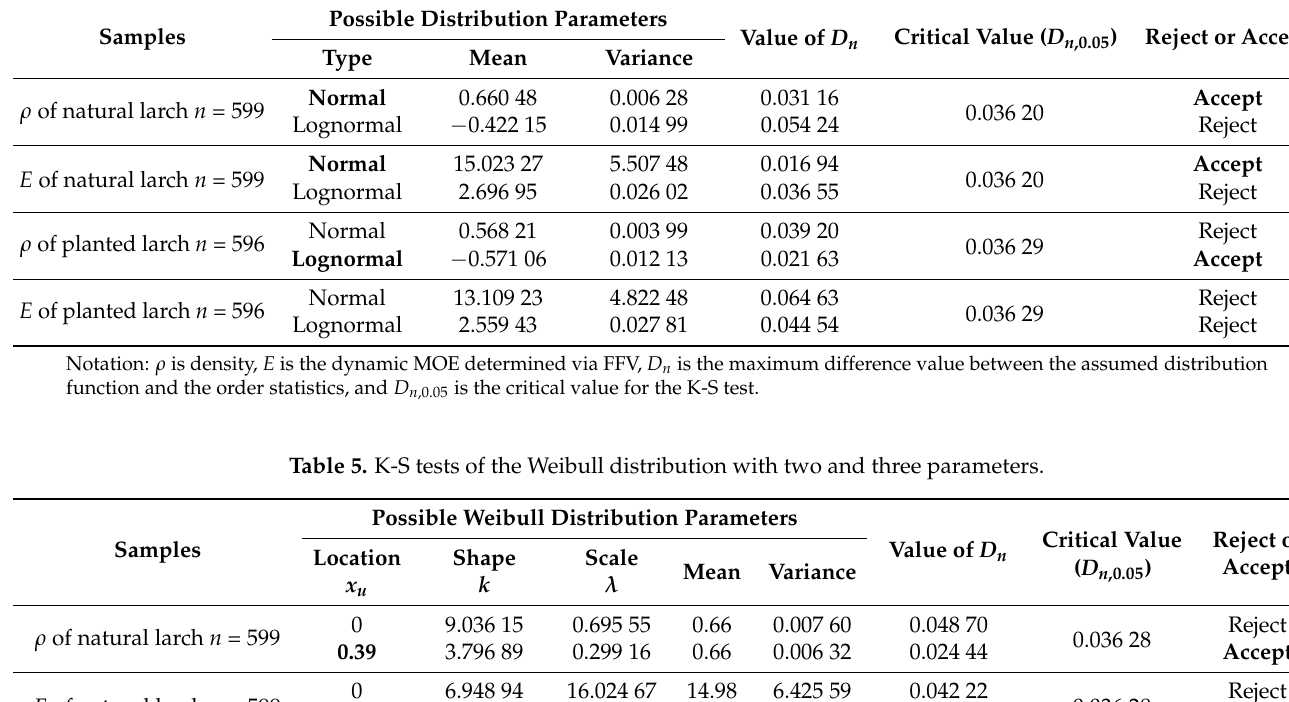
( C ) Density of planted larch ( D ) MOE Dynamic of planted larch Figure 6. D n values of the Weibull distribution compared with the K-S critical value. Note: D n is the maximum difference value between the assumed distribution function and the order statistics, and 𝐷 𝑛,0.05 is the critical value for the K-S test. Only the D n is smaller than 𝐷 𝑛,0.05 , so the Weibull distribution with three parameters was accepted after the K-S test. Table 4. K-S tests of the normal and lognormal distributions based on the estimated parameters.